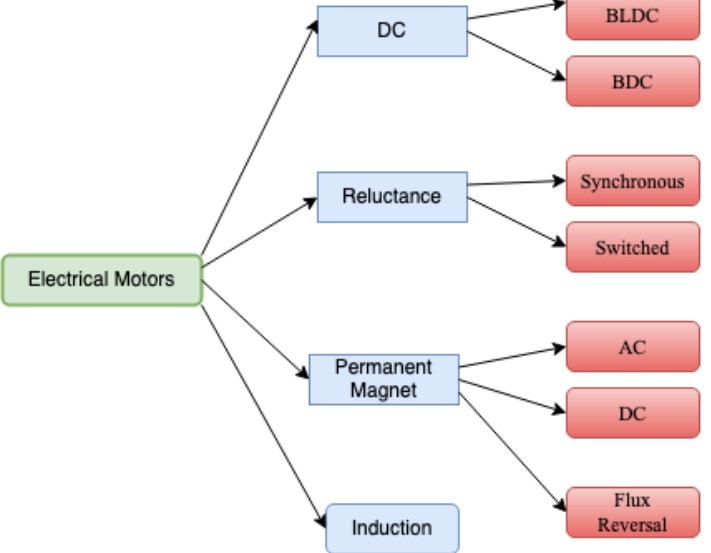
Figure 8. Main electric motor technologies currently available for EVs [34 – 39].